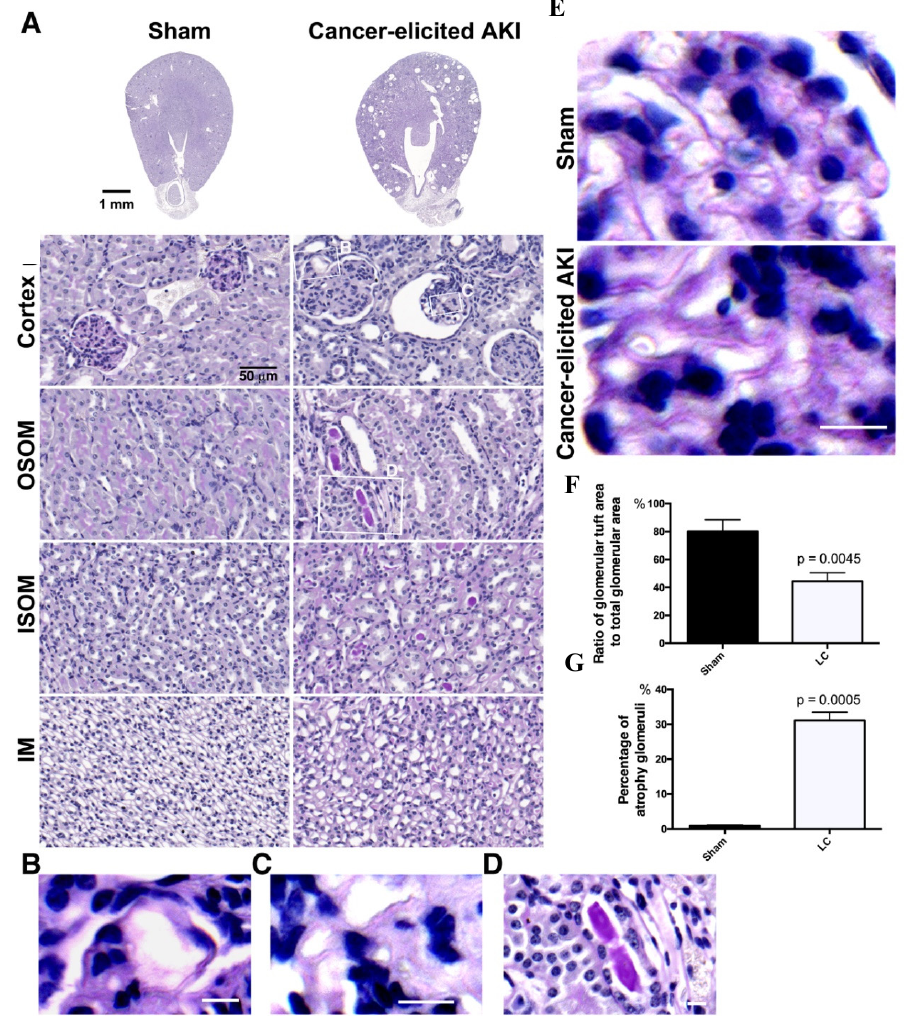
Figure 2. Histochemical examination of the kidneys of lung cancer mice. ( A ) Periodic acid Schiff (PAS) staining colored glycoproteins in brush borders in renal tubules and glomerular arteries.